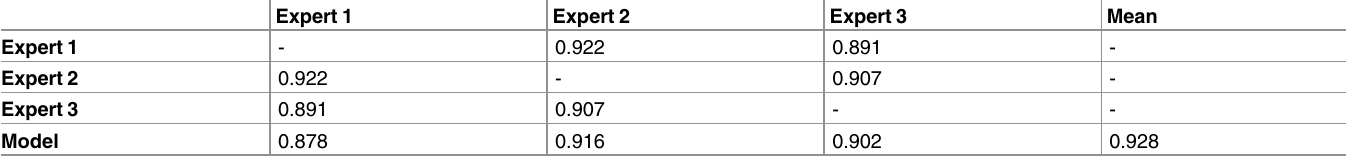
Table 4. Pearson’s correlation (r) between the three expertsscores and the output of the fuzzy subsystem 2 –level of running experiencein the real dataset (n = 100).